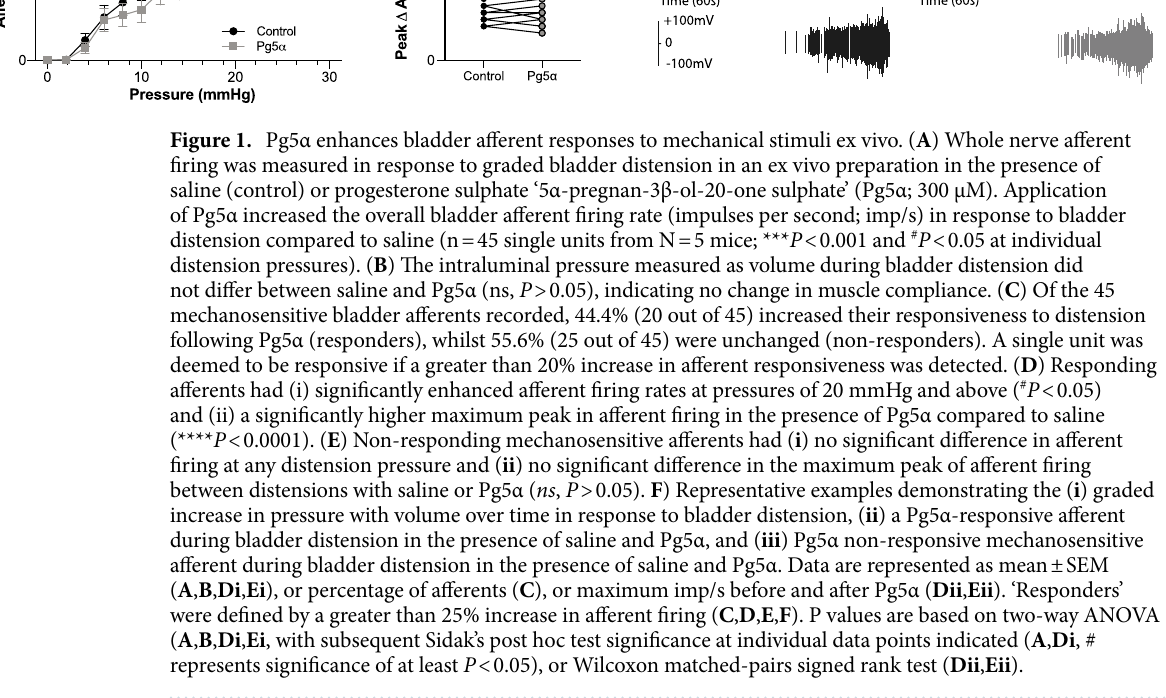
Gpbar1 −/− mice, the mechanical hypersensitivity to distension following CCDC compared to saline was com- pletely abolished (Fig. 3A). As in wildtype mice there was no change in muscle compliance between CCDC and saline experiments (Fig. 3B), confirming that the absence of altered sensitivity was not caused by changes in bladder muscle function. Interestingly, single unit analysis of the afferents showed that while the majority of afferents (82.9%; 29/35) reflected the overall lack of sensitivity to CCDC, mechanical hypersensitivity was observed in 17.1% (6/35) of mechanosensitive afferent fibres (Fig. 3C). These CCDC-responsive neurons dem- onstrated mechanical hypersensitivity specifically at 10 mmHg (Fig. 3Di) and an increase in the maximum peak